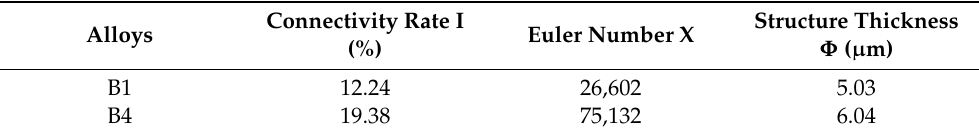
Figure 10. 3D structure rendering of alloy phase and eutectic Si: ( a , c ) B1 alloy; ( b , d ) B4 alloy. Table 2. Eigenvalues of 3D network structure of alloys.